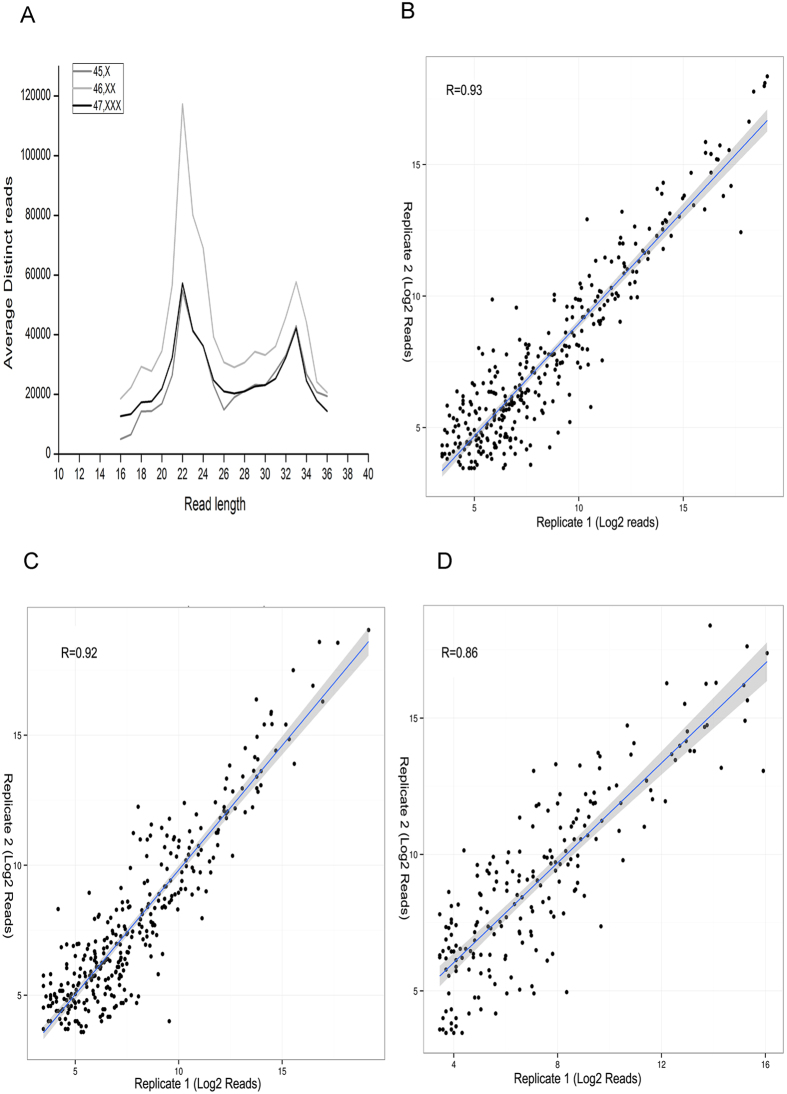
miRNA NGS raw data statistic.(A) Read length distribution of mapped reads. B-D) Coefficient of correlation for biological duplicate miRNA sequencing in (B) 45,X (C) 46,XX (D) 47,XXX.